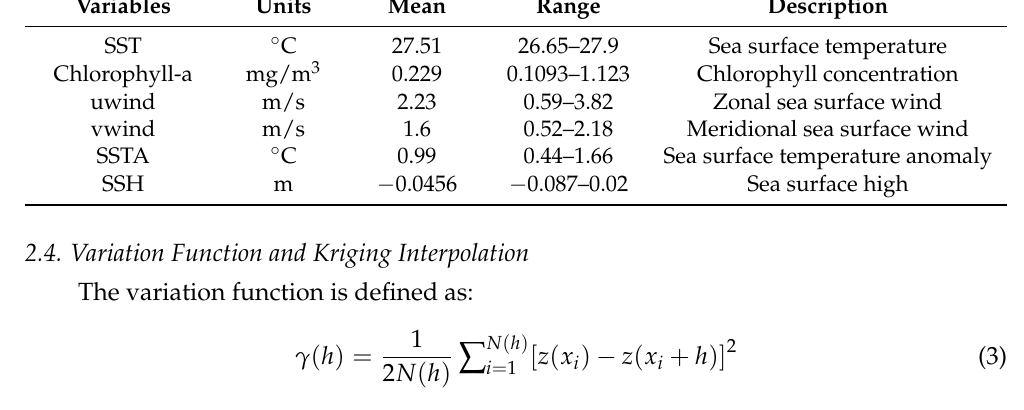
Table 2. The units, mean, range and description of environmental variables in GAM model.